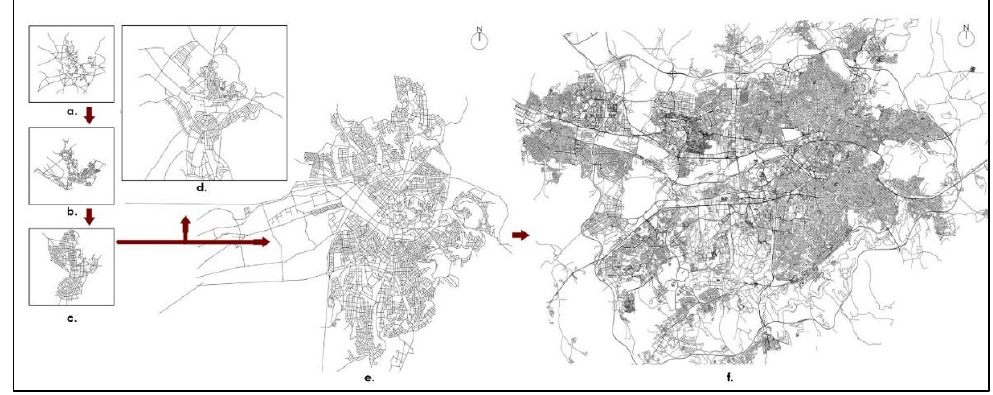
Figure 4 The axial maps of the analysed historical periods (a. 1839 map; b. 1924 map; c. Lörcher Plan; d. Jansen Plan; e. Yucel-Uybadin Plan; f. Today Ankara).